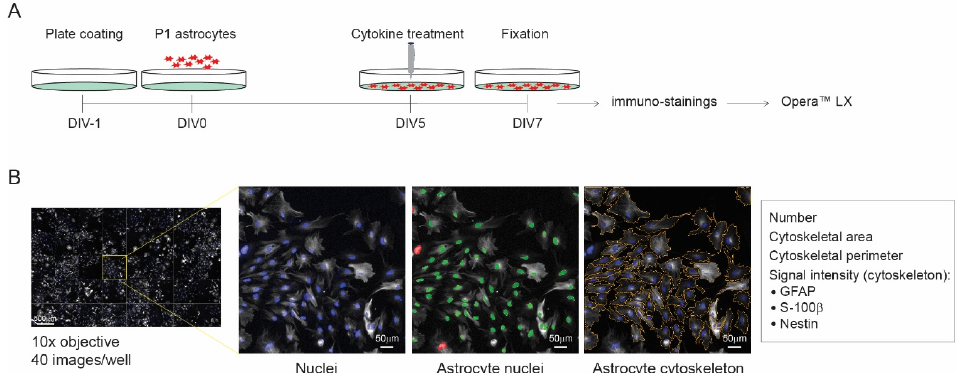
Figure 1. AstroScan. ( A ) Experimental design of the cytokine-induced reactive astrogliosis model. ( B ) Left: Overview image showing 40 fields per well (96-well plate) taken with a 10× objective from the Opera™ LX (PerkinElmer) automated confocal microscopy. Close-up: Example image of one field. Columbus software was used to identify and select single astrocyte nuclei (based on DAPI intensity, size, and roundness) as well as the astrocyte cytoskeletal area and perimeter (based on GFAP immunostaining). GFAP, Nestin, and S-100 β protein levels were quantified for selected astrocytes.